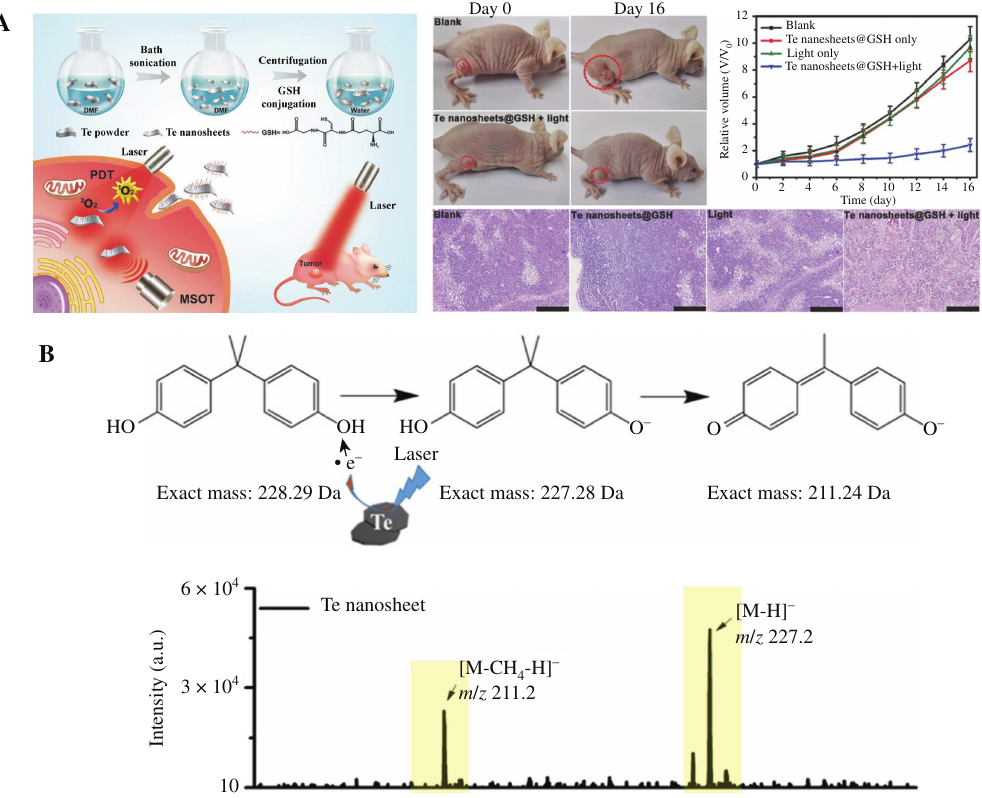
Figure 15: The biomedical applications of tellurene. (A) Schematic procedure of Te nanosheets@GSH and their potential applications in multispectral optoacoustic tomography and photodynamic therapy. The growth rate of tumor was significantly suppressed. Reproduced with permission [179]. Copyright 2018, The Royal Society of Chemistry. (B) Schematic detection process of bisphenol A and the mass spectra of bisphenol A obtained by utilizing Te nanosheet. Reproduced with permission [180]. Copyright 2018, Springer Nature.